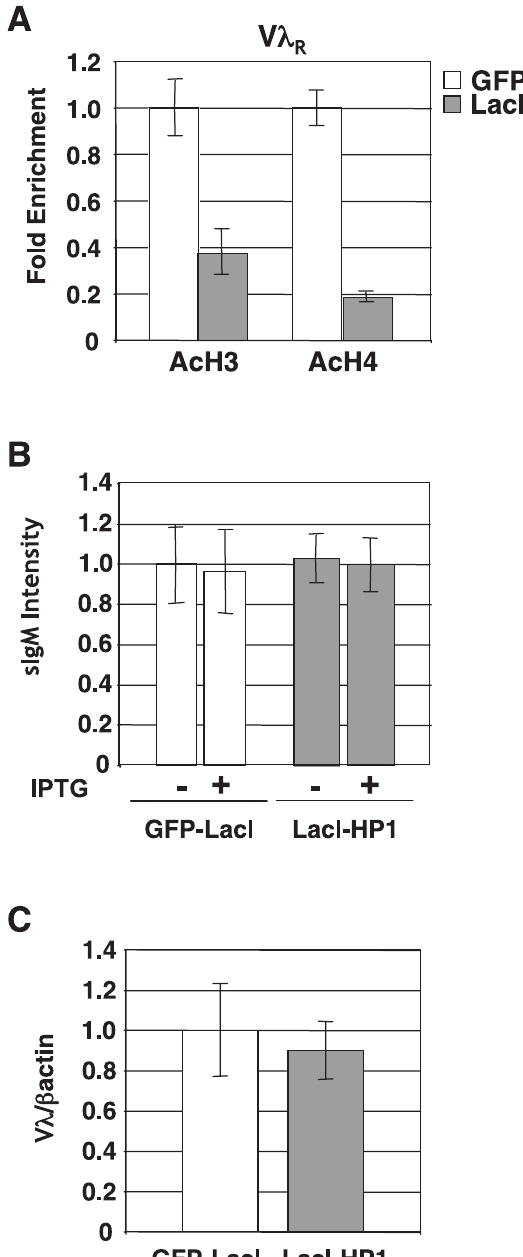
Figure 4. Tethered HP1 Does Not Affect Ig k Expression (A) Relative enrichment of AcH3 and AcH4 at V k R in DT40 PolyLacO-V k R GFP-LacI and DT40 PolyLacO-V k R LacI-HP1 transfectants. Enrichment values were normalized to the DT40 PolyLacO-V k R GFP-LacI control. Bars indicate standard deviation of four separate amplifications of increasing amounts of template DNA. (B) Relative intensity of sIgM expression in DT40 PolyLacO- k R GFP-LacI and DT40 PolyLacO- k R LacI-HP1 transfectants cultured in the presence or absence of 250 l M IPTG. sIgM levels were quantitated by measuring intensity of staining with mouse anti-chicken IgM antibody, and normalized to the level in DT40 PolyLacO- k R GFP-LacI transfectants. Details as in (A). (C) Relative levels of V k R transcripts in DT40 PolyLacO- k R GFP-LacI and DT40 PolyLacO- k R LacI-HP1 transfectants. Transcript levels were quanti- tated by reverse transcriptase–PCR and normalized to the level in DT40 PolyLacO- k R GFP-LacI transfectants. Details as in (A).